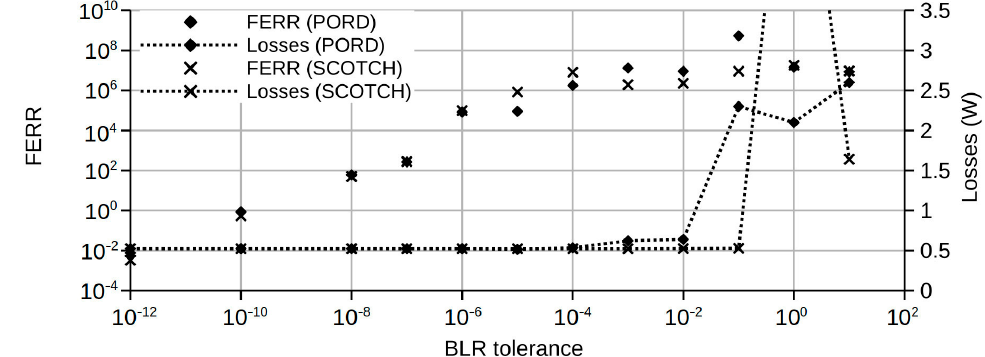
Figure 7. Dependence of the relative forward error value of the calculated SLAE solution and the calculated value of the eddy current power (losses) on the given tolerance of the low-rank SLAE approximation.